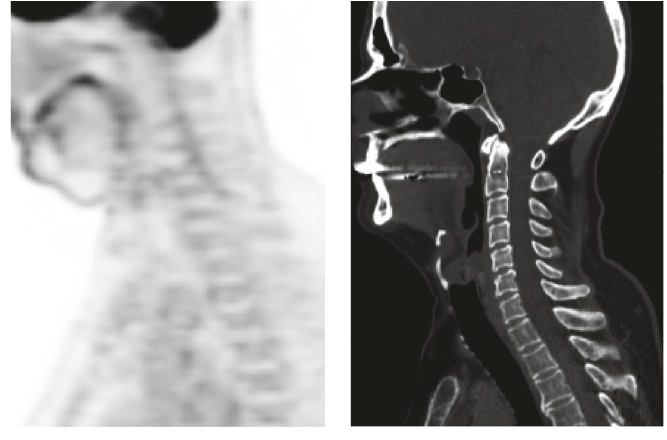
(a) (PET/CT) : Sagittal FDG PET does not demonstrate any abnormal focal uptake within the cervical or thoracic spine